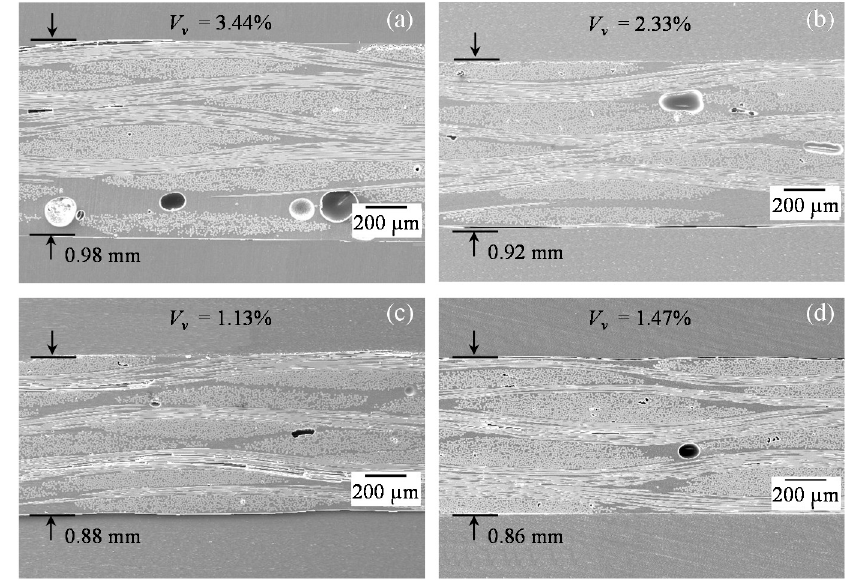
Figure 7. Scanning electron microscopy (SEM) images of plain weave laminates (at 35× magnification) made by WLVB process and sliding lifting magnet on the saturated lay-up with ( a ) 0 pass; ( b ) 1 pass; ( c ) 6 passes; and ( d ) 12 passes.